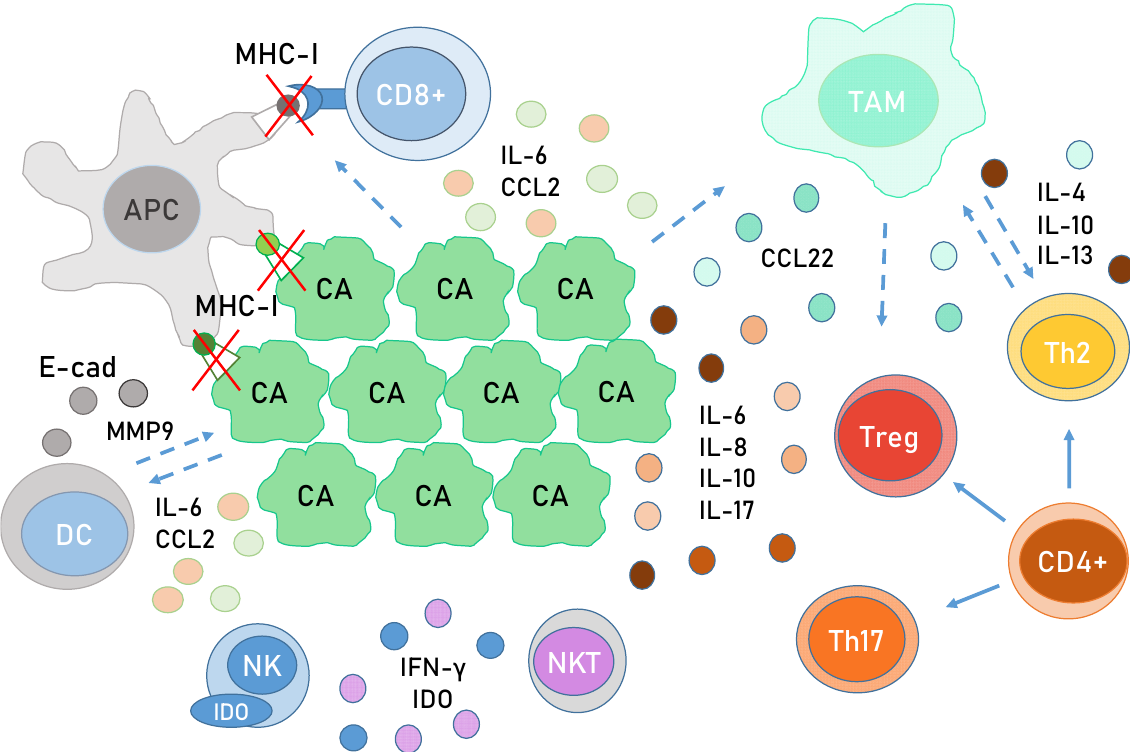
Figure 5. The immune microenvironment of HPV-associated cancers. HPV-infected cells express less MHC-I receptors and E-cadherin (E-cad) and, as a consequence, attract and retain less APCs and activate less CD8+ cells. Tumour cells secrete various cytokines and chemokines; IL-6 inhibits DC maturation and contributes to monocyte maturation into TAMs, as does CCL2, while immature DCs secrete the pro-tumorigenic MMP9 under the influence of IL-6. IDO secreted by tumour cells and NKT cells inhibits the cytotoxic activity of NK cells. Naive CD4+ cells mature into T helper and T regulatory cells in the tumour environment. Th2 cells secrete cytokines, which induce monocyte maturation into TAM, whereas TAMs produce the same interleukins that also promote CD4+ differentiation into Th2, creating a feedback loop. TAMs also promote the recruitment of immune-suppressive Tregs with CCL22 and the maturation of CD4+ cells into Tregs with IL-10. Th2,